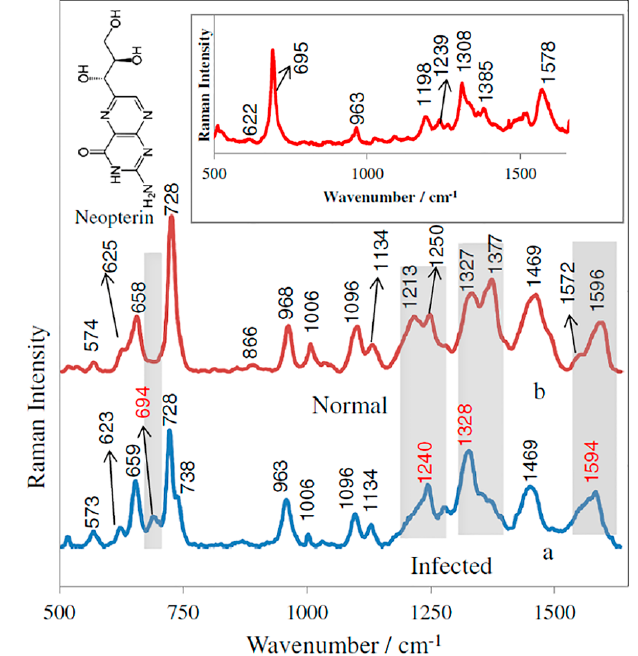
Figure 8. Comparison of the SERS spectrum of the CSF samples infected by N. meningitidis ( a ) versus that of the normal (control) CSF samples ( b ). Samples of CSF were deposited onto the Si/ZnO/Au substrate and measured in situ. The inset shows the SERS spectrum of neopterin adsorbed onto the Si/ZnO/Au substrate from 35.0 nmol/L neopterin solution in a PBS buffer. The presented SERS spectra were averaged from ten measurements in different places of the SERS nanostructures [126].